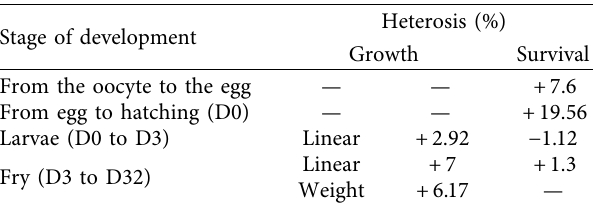
Table 3: Heterosis values of growth and survival in reciprocal hybridizations of C. gariepinus × C. jaensis by stage of development. Stage of development